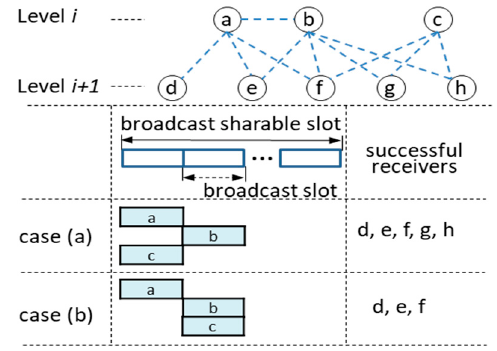
Figure 1. The effect on using the notion of the slotted Aloha within a broadcast sharable slot.